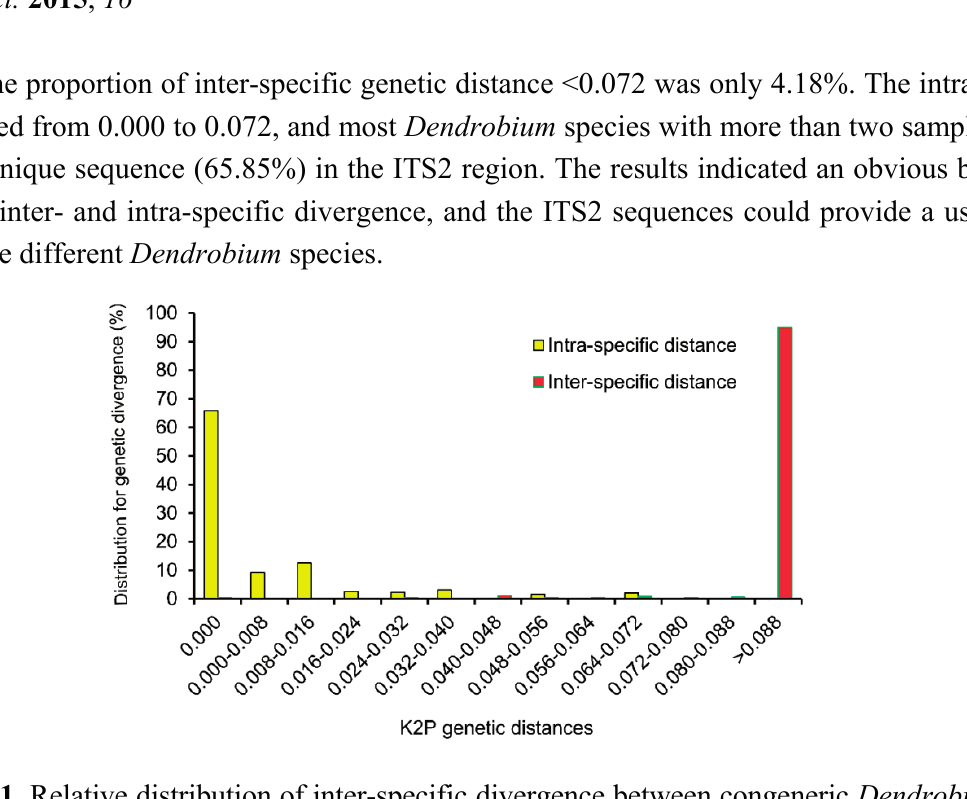
Figure 1. Relative distribution of inter-specific divergence between congeneric Dendrobium species and intra-specific variation in the ITS2 region using K2P genetic distance.